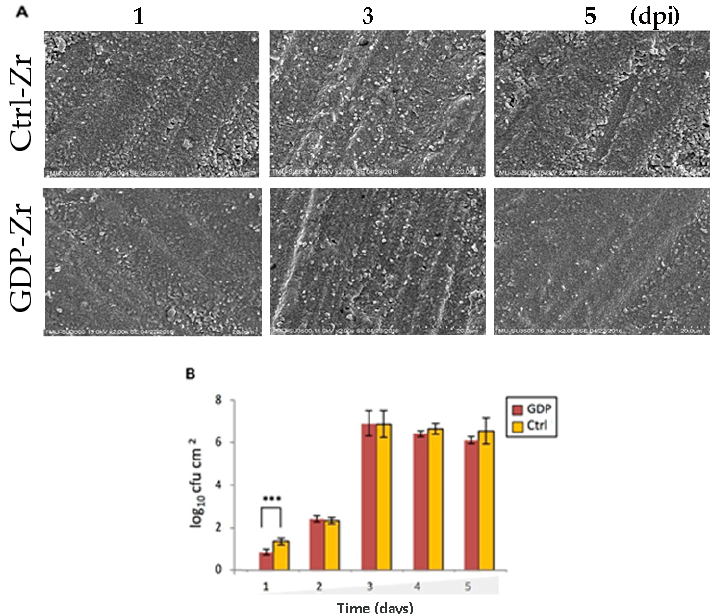
Figure 7. Morphology of the P. gingivalis that adhered to the Zr discs after treatment. ( A ) Representative SEM micrographs illustrating the growth of bacteria, showing a relatively lower number of bacteria on the GDP-Zr discs. Magnification: ×2000, scale bar: 20 μ m ( B ) The quantified result of the SEM micrographs. *** p < 0.001.